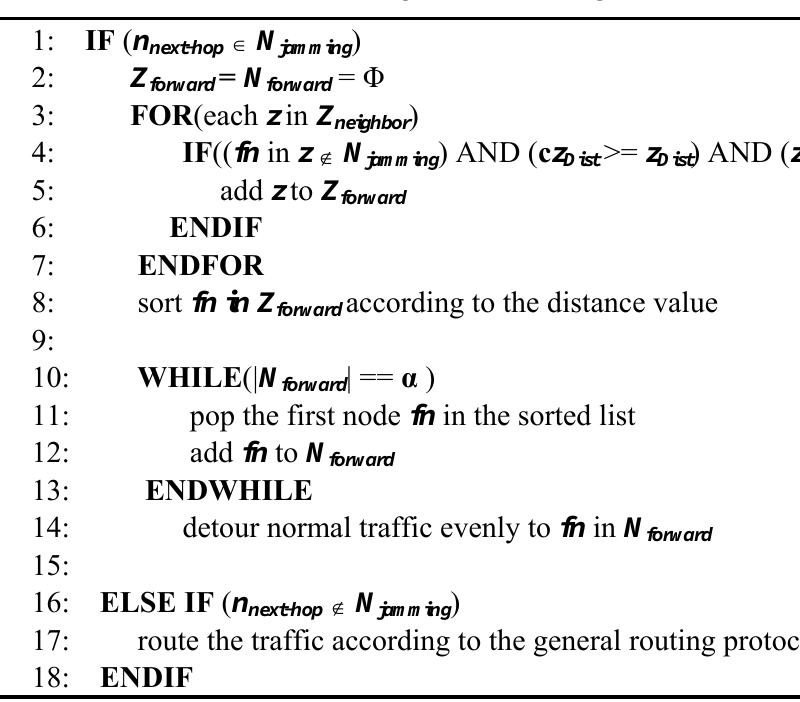
Table 2. Algorithm selecting forward nodes at detour